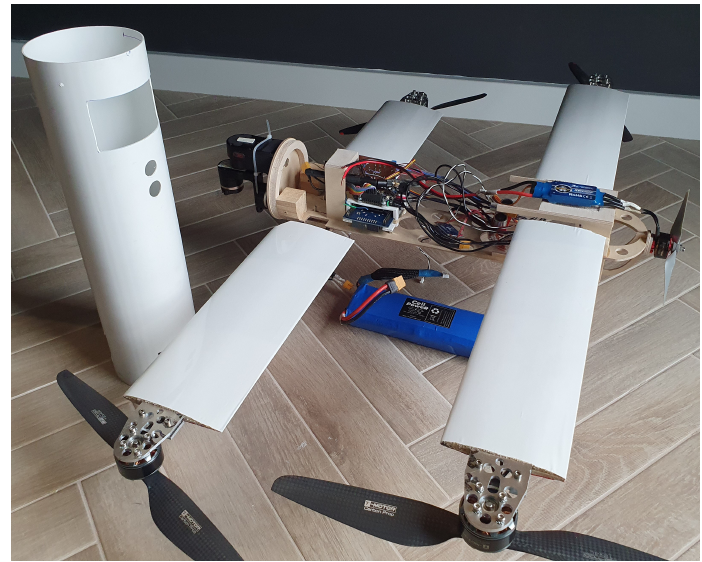
Figure 17. The final design of Elka1Q fuselage—a PVC tube with internal plywood